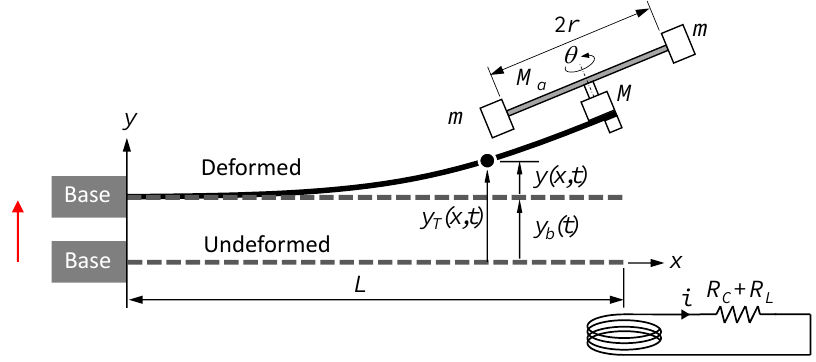
Figure 2. System parameters for analytical modeling